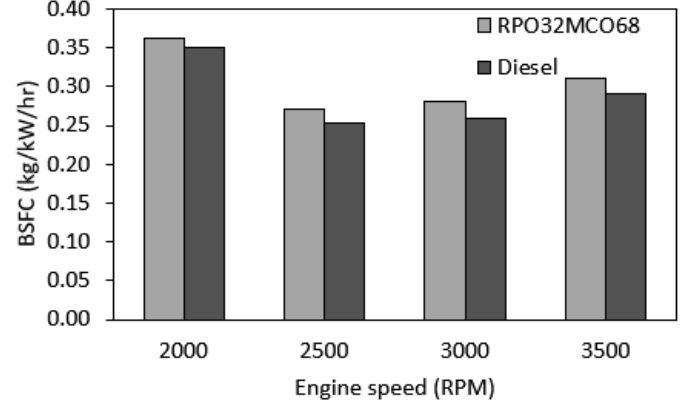
Figure 12. Comparison of brake specific fuel consumption (BSFC) as a function of engine speeds.